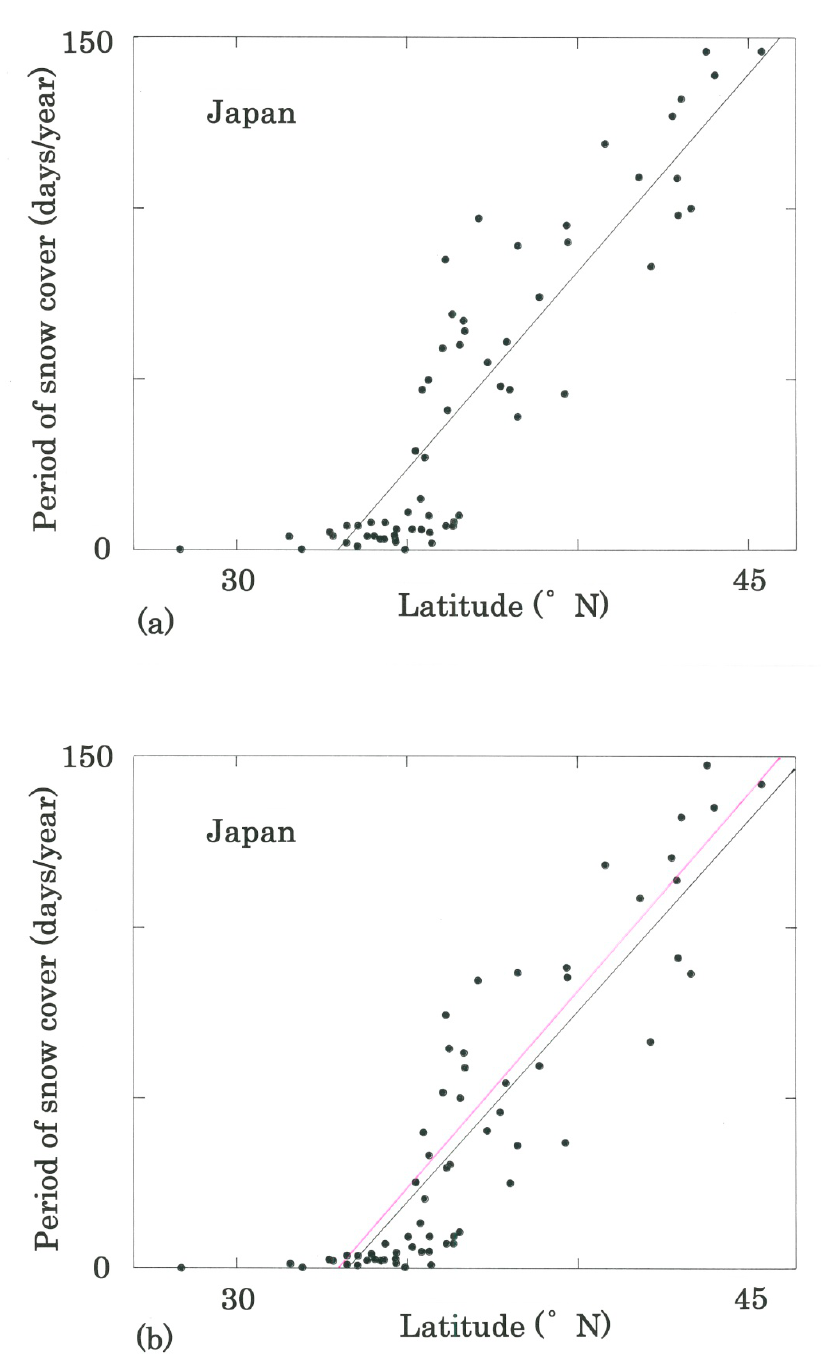
Figure 6. The period of snow cover versus the latitude. Null data are excluded from the plot. (a) In 1980. The line superimposed in the plots represents the optimal linear regression ( r = 0.890 with d = 1.634 > d U = 1.47 for n = 65). ( b ) In 2010. The black line in the plots represents the optimal linear regression ( r = 0.888 with d = 1.758 > d U = 1.47 for n = 65). The regression of ( a ) 1980 is superimposed with the pink line. Table 5. Top ‐ twenty Japanese stations in the rotation angle of the monthly distributions of temperatures from Period I (1931–1960) to II (1951–1980). Rank Ｓｔａｔｉｏｎ Ｌａｔ．（ ° ′ ） θ （ ° ） Δ Ｔ（Ｋ）